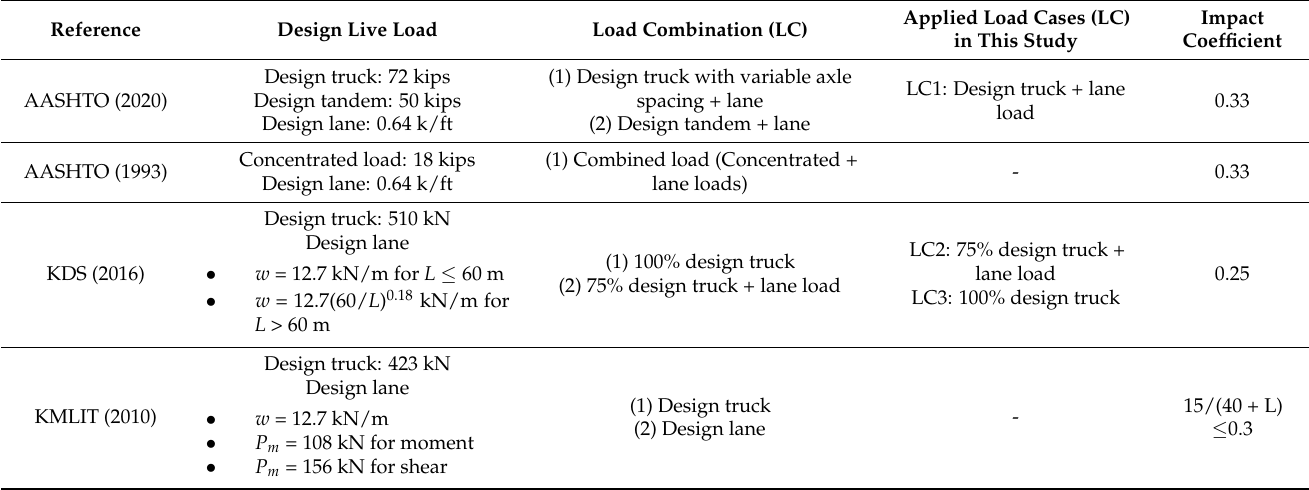
Table 1. Design live loads and load combinations specified in the design codes and applied load cases (LC) in this study. Reference